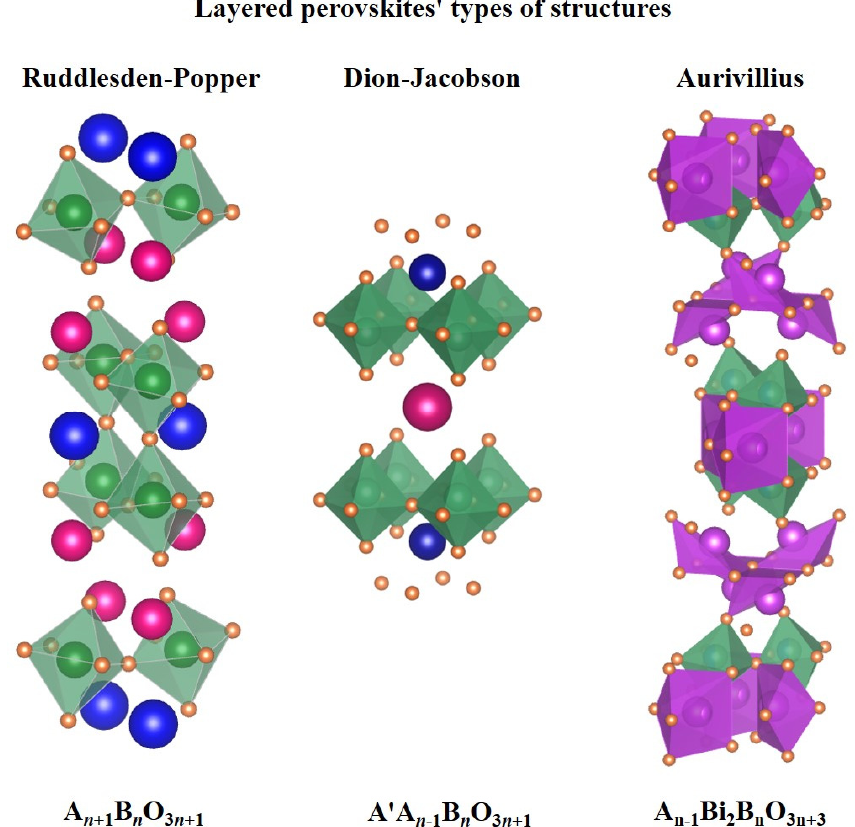
Figure 1. The images of layered perovskites types of structures: Ruddlesden-Popper (A n +1 B n O 3 n +1 ), Dion–Jacobson (A’A n − 1 B n O 3 n +1 ), and Aurivillius (A n − 1 Bi 2 B n O 3 n +3 ) (from left to right) with n = 2.